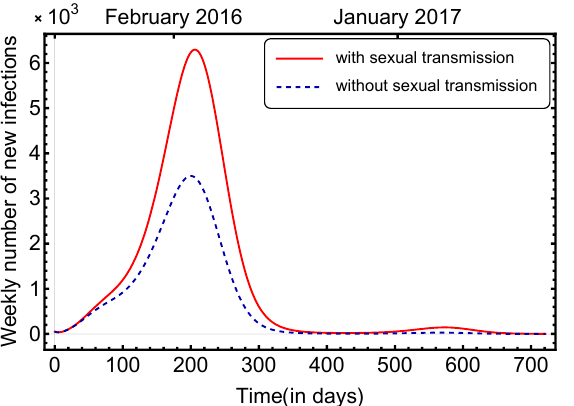
Figure 5. Number of the symptomatically infected and estimated number of symptomatically infected humans in the absence of sexual transmission.